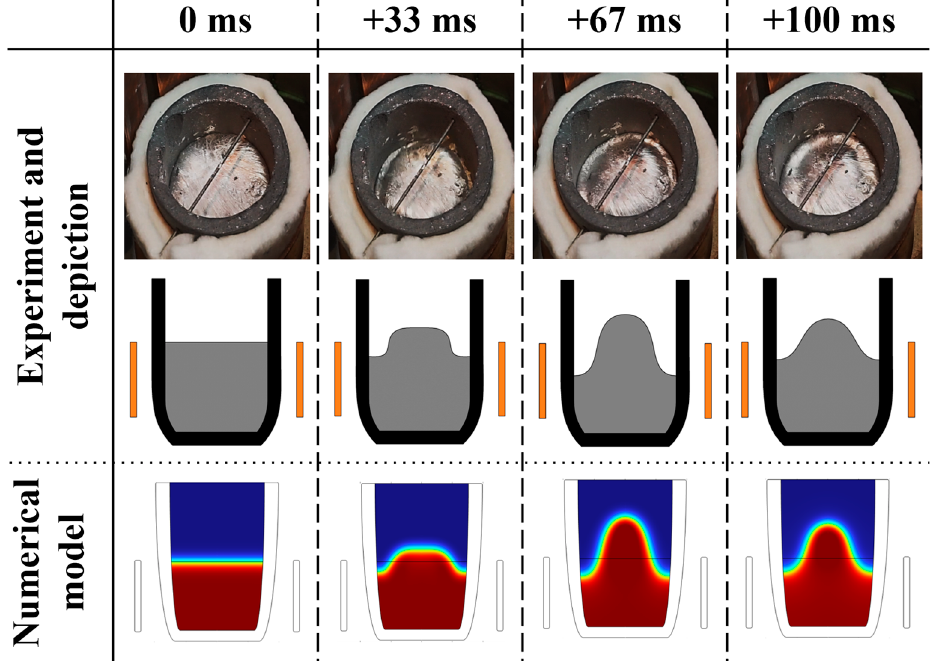
Figure 7. Free surface deformation caused by 26 kA current pulse at different times captured by camera. Numerical results are compared to experiment captures and depictions of the experiment.